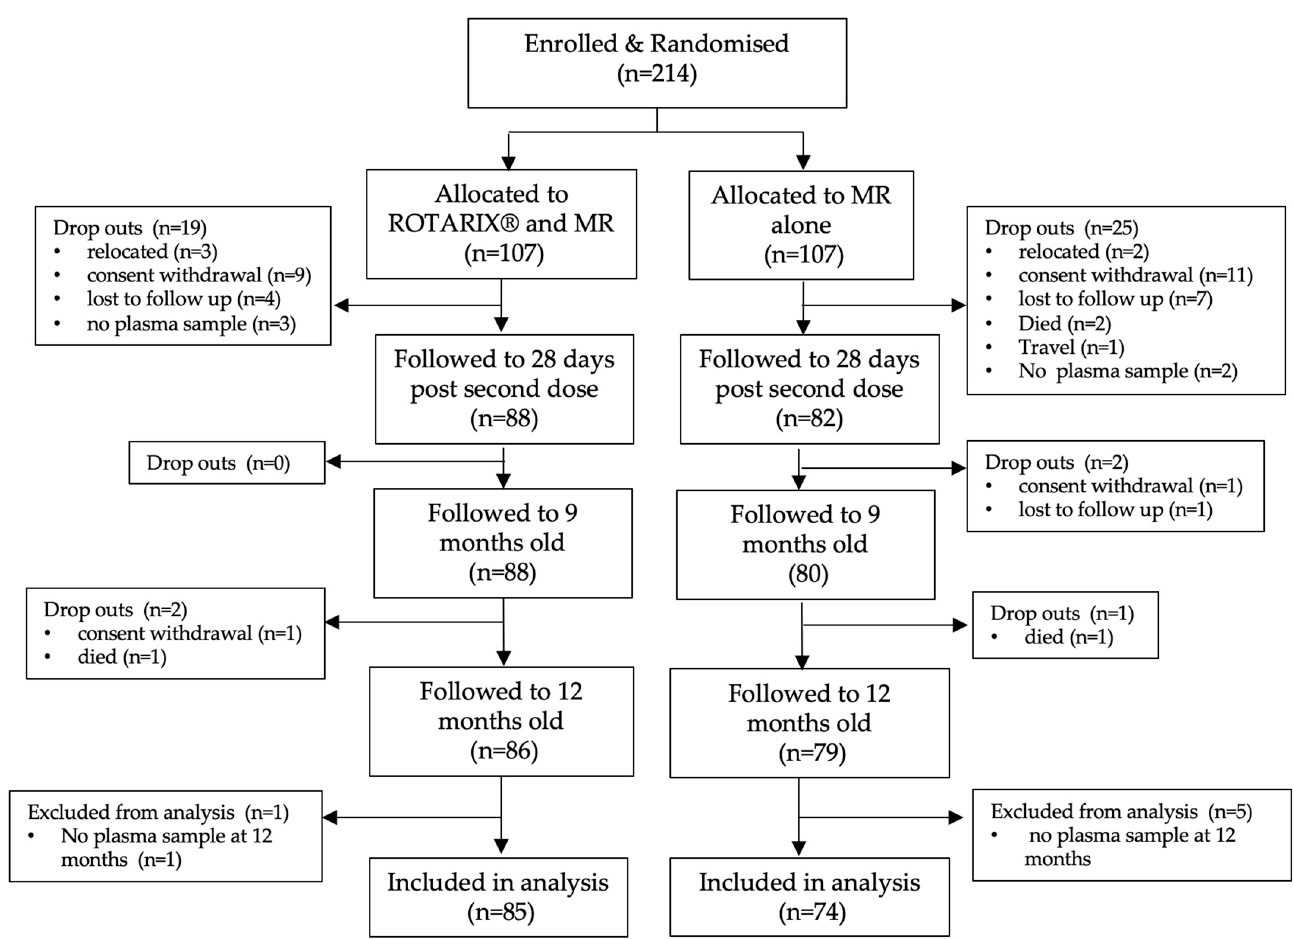
Figure 1. Study participant flow chart. Abbreviations: MR (measles/rubella vaccine).